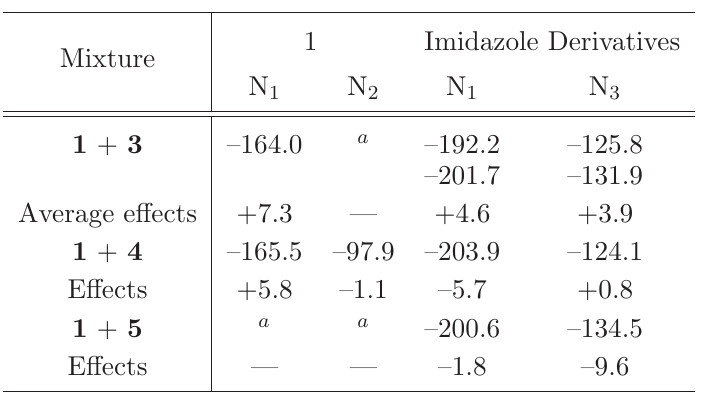
Table 6 15 N NMR CPMAS chemical shifts (ppm) and effects (∆ δ = δ mixture – δ azole ) of azole mixtures.